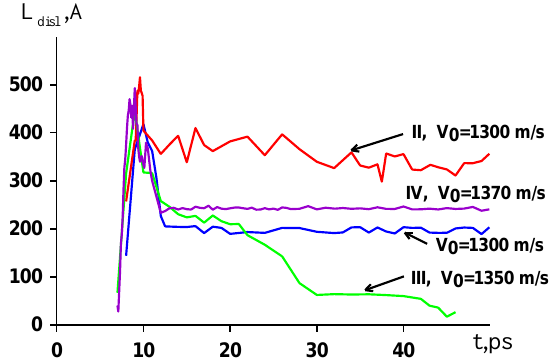
Fig. 3. Total length of dislocations in the cluster versus